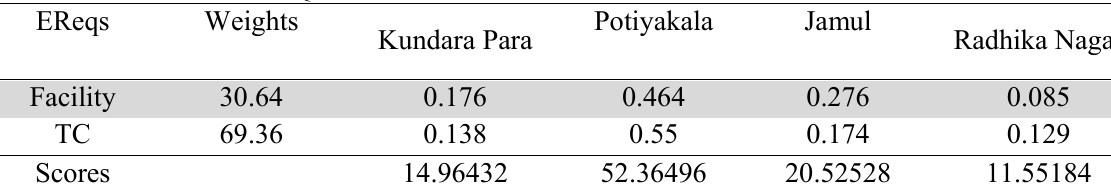
Scores of the hierarchical QFD model